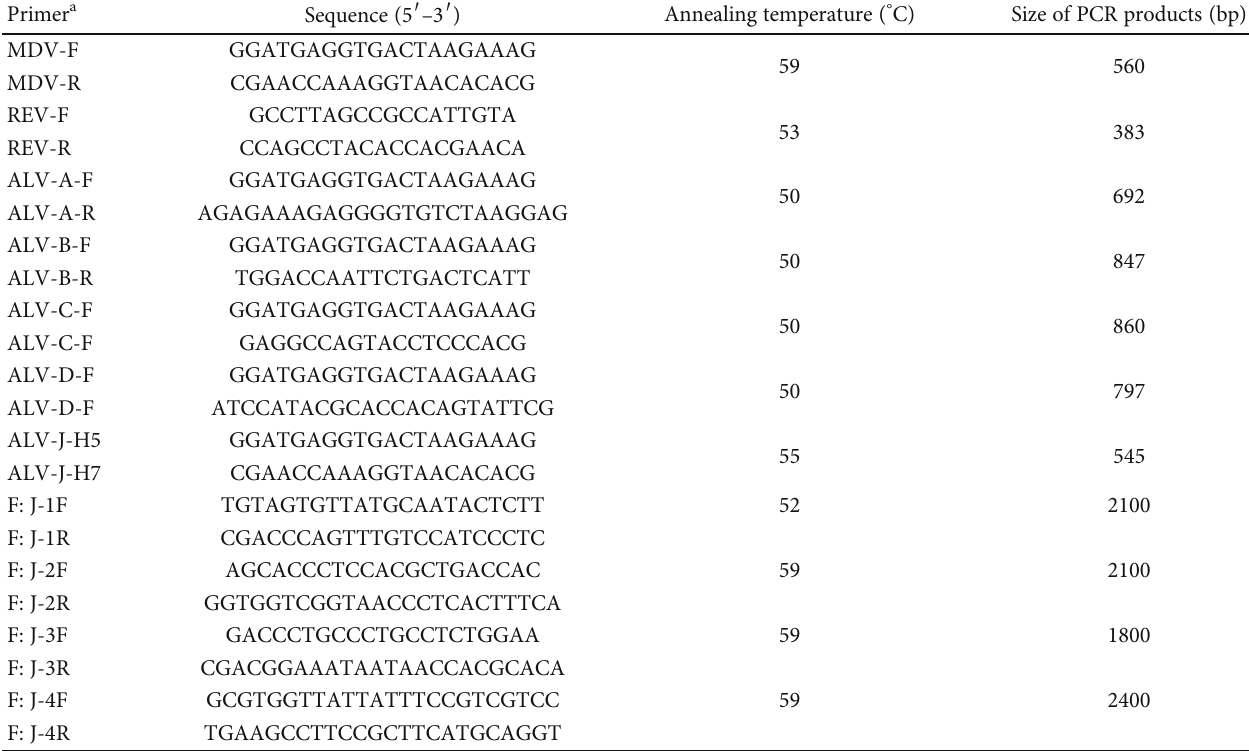
Table 1: The primers used to detect the ALVs and to amplify the full-length proviral genome of ALV-J isolates. Primer